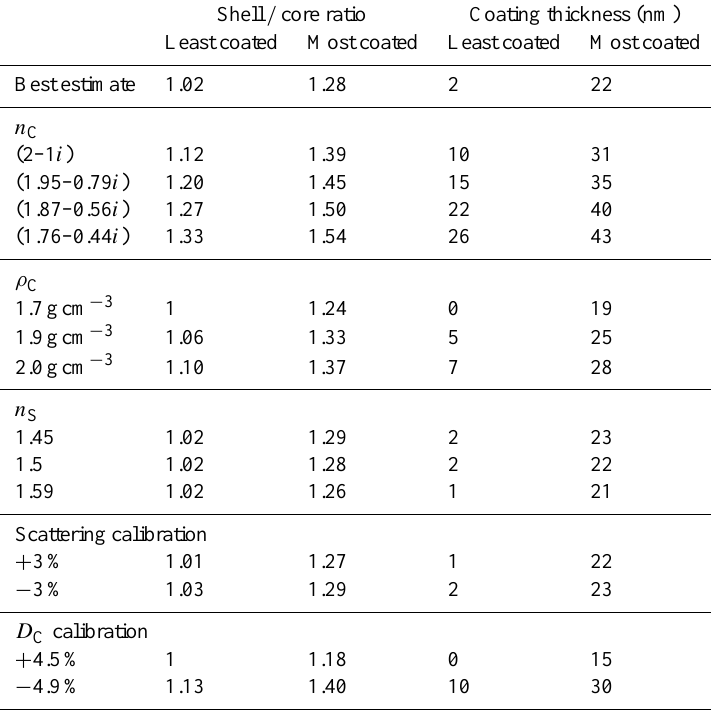
Table 2. Median shell / core ratios and absolute coating thicknesses with varied assumptions about ρ C , n C and n S and varied instrument calibrations. All other parameters were held at their best estimate values, described in the text. For clarity, increasing the scattering calibration refers to increasing the signal of a 200nm PSL used to scale the Mie table, whereas increasing the D C calibration refers to increasing D C . Shell / core ratio Coating thickness (nm) Least coated Most